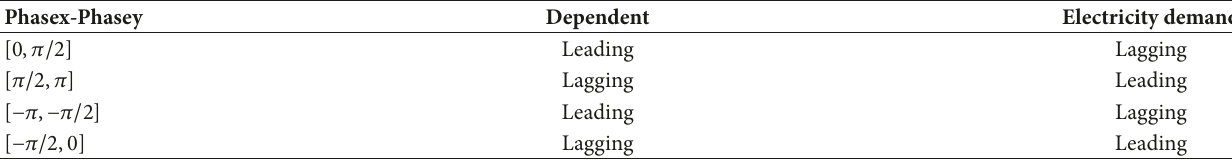
Table 1: Phase differences and their